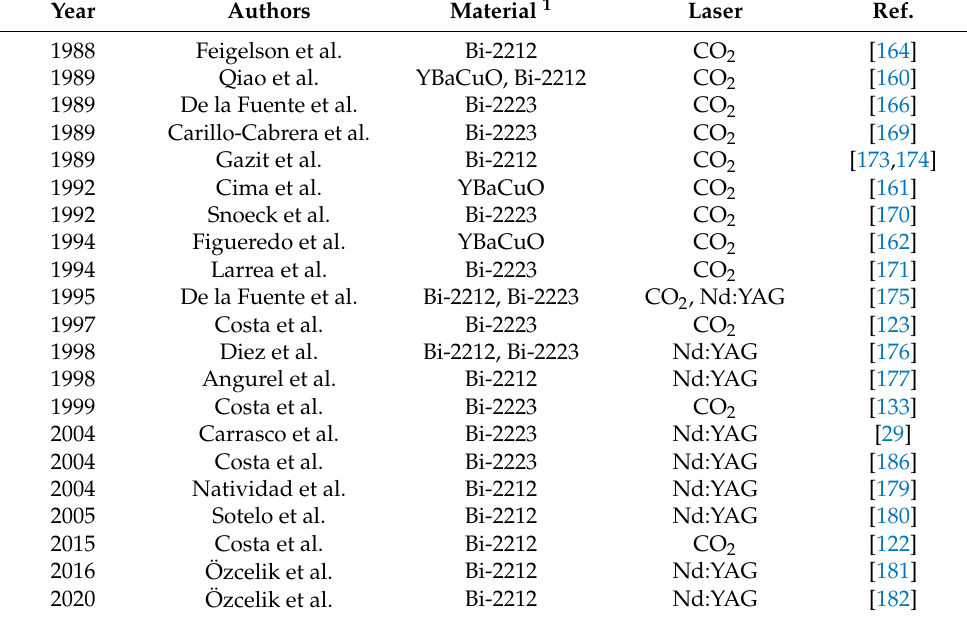
Table 6. Superconducting materials produced by